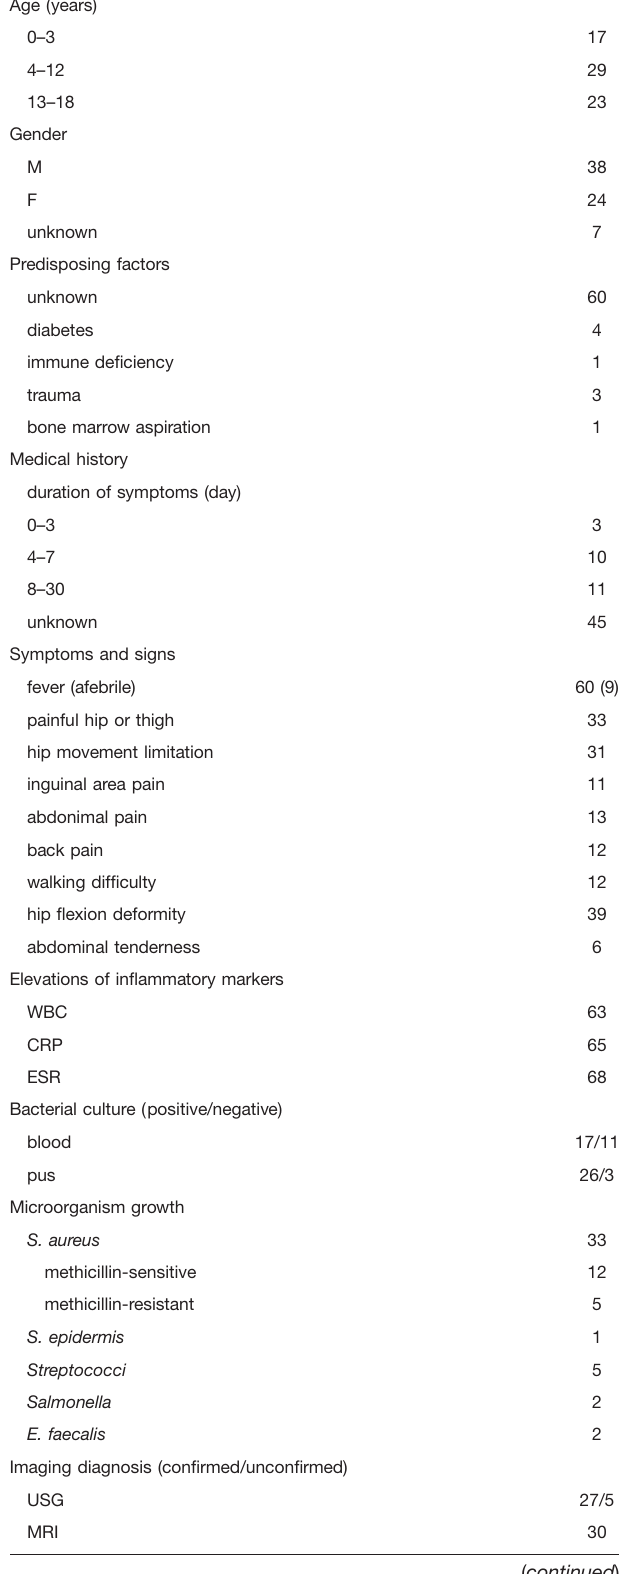
TABLE 1 | Summary of the clinical characteristics (8 – 50), N